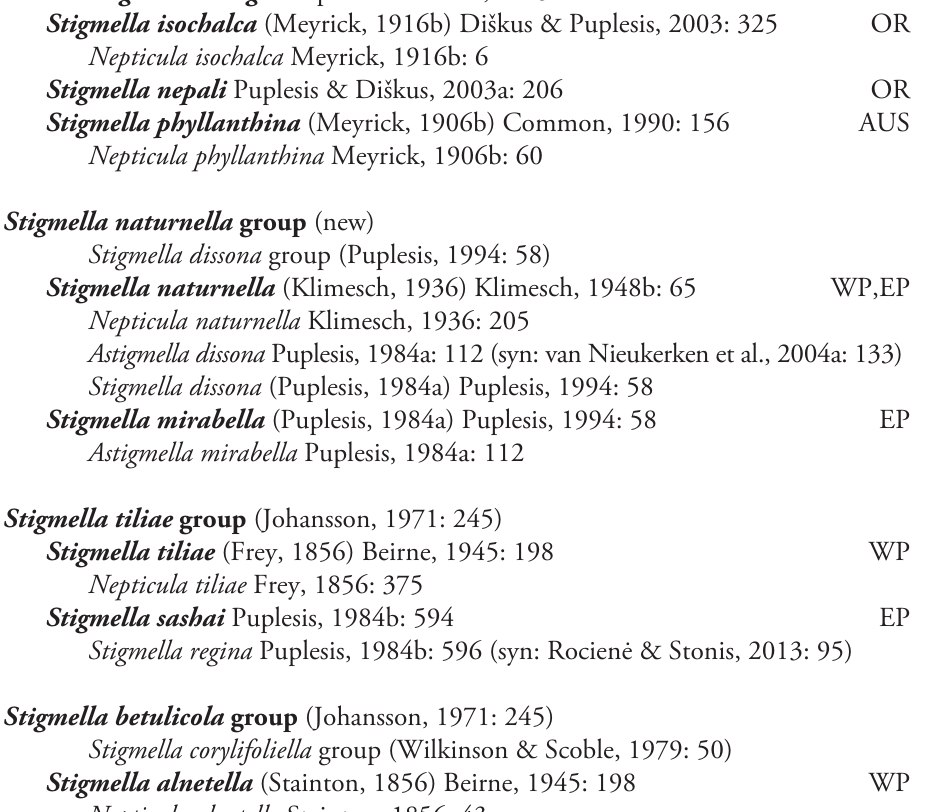
‡ Stigmella celtivora Dovnar-Zapolski, 1969: 39 NNLM Stigmella zizyphi Walsingham, 1911: 190 WP,AFR